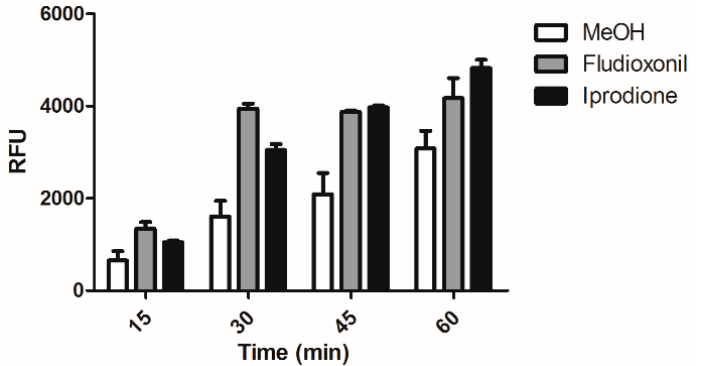
Figure 4. Phagocytosis of fludioxonil and iprodione treated C. albicans by the murine macrophage cell line RAW 264.7. RFU: relative fluorescence units.